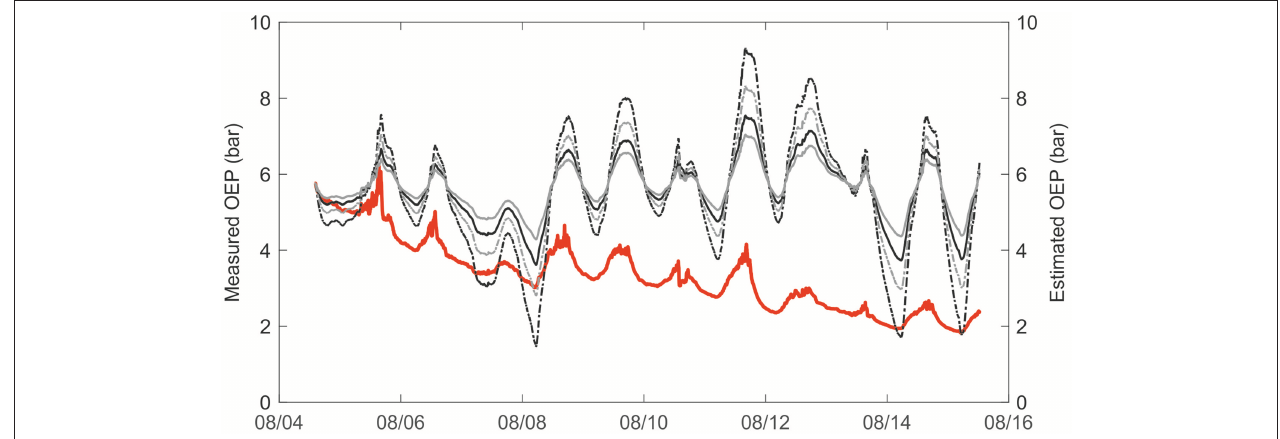
FIGURE 5 | Measured oleoresin exudation pressure (OEP) in a mature Scots pine (Tree 1) in 2017 compared to modeled resin pressure, based on thermal expansion and gas solubility in resin. Measured OEP in solid red. Estimated OEP with high CO 2 concentration (8%) and elasticity coefficient 5MPa in solid black line, and with high CO 2 concentration (8%) and elasticity coefficient 10 MPa in dashed black line. Estimated OEP with low CO 2 concentration (2%) and elasticity coefficient 5 MPa in solid gray line, and with low CO 2 concentration (2%) and elasticity coefficient 10 MPa in dashed gray